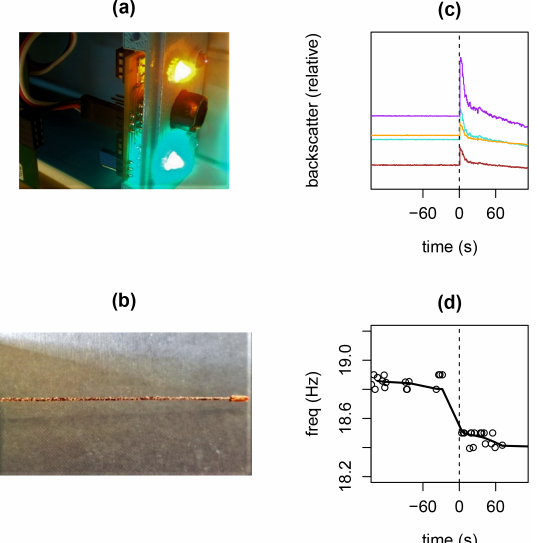
Figure 14. Comparison of (a) optical detector and (b) oscillating wire ash collector, shown after the collecting wire became coated with pumice. Panel (c) shows data from the optical detector’s four channels (relative responses), during which pumice was introduced, at time 0s. Panel (d) shows the simultaneous change in vibration frequency of the adhesive-coated collecting wire, as the pumice was collected.